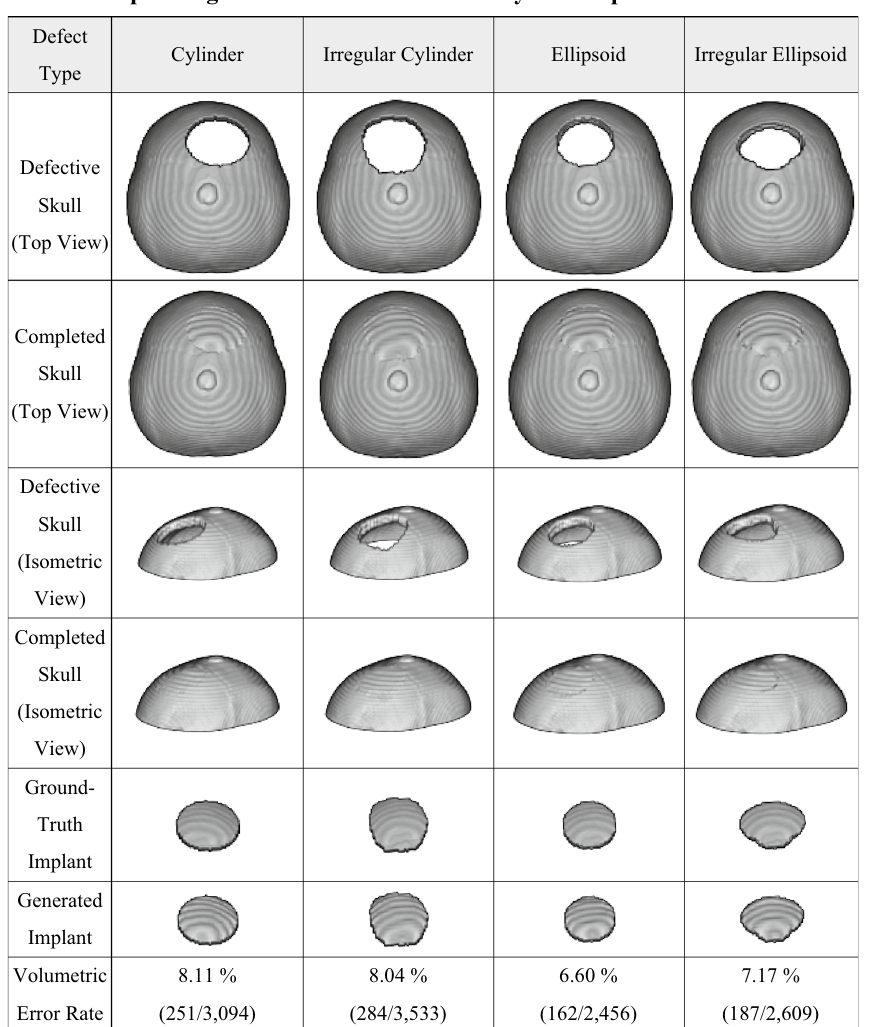
Figure 2. Automatic generation of implants for defective cranial models by the proposed deep learning system. The defects are made by Boolean subtraction of 4 types of 3D masks from an intact skull